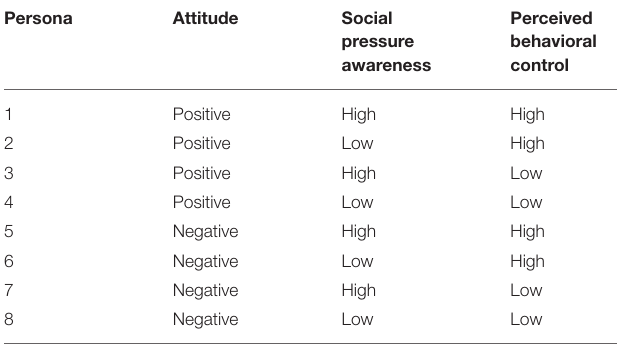
TABLE 1 | Possible persona segments derived from the TPB.